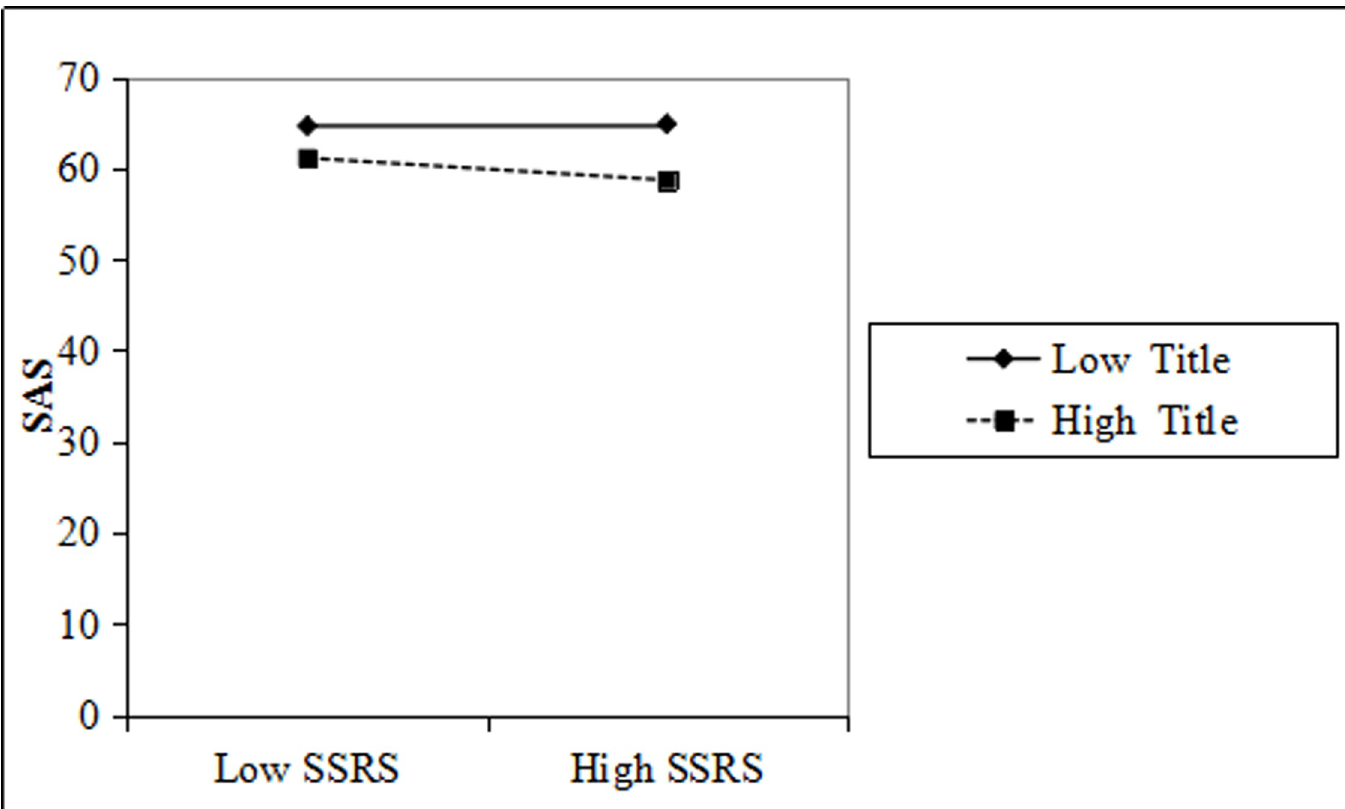
Fig 6. Title moderation interaction diagram for SSRS and physician SAS.